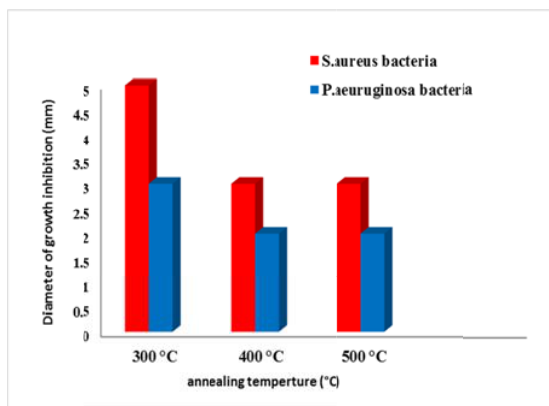
Fig.10: Gr rowth of